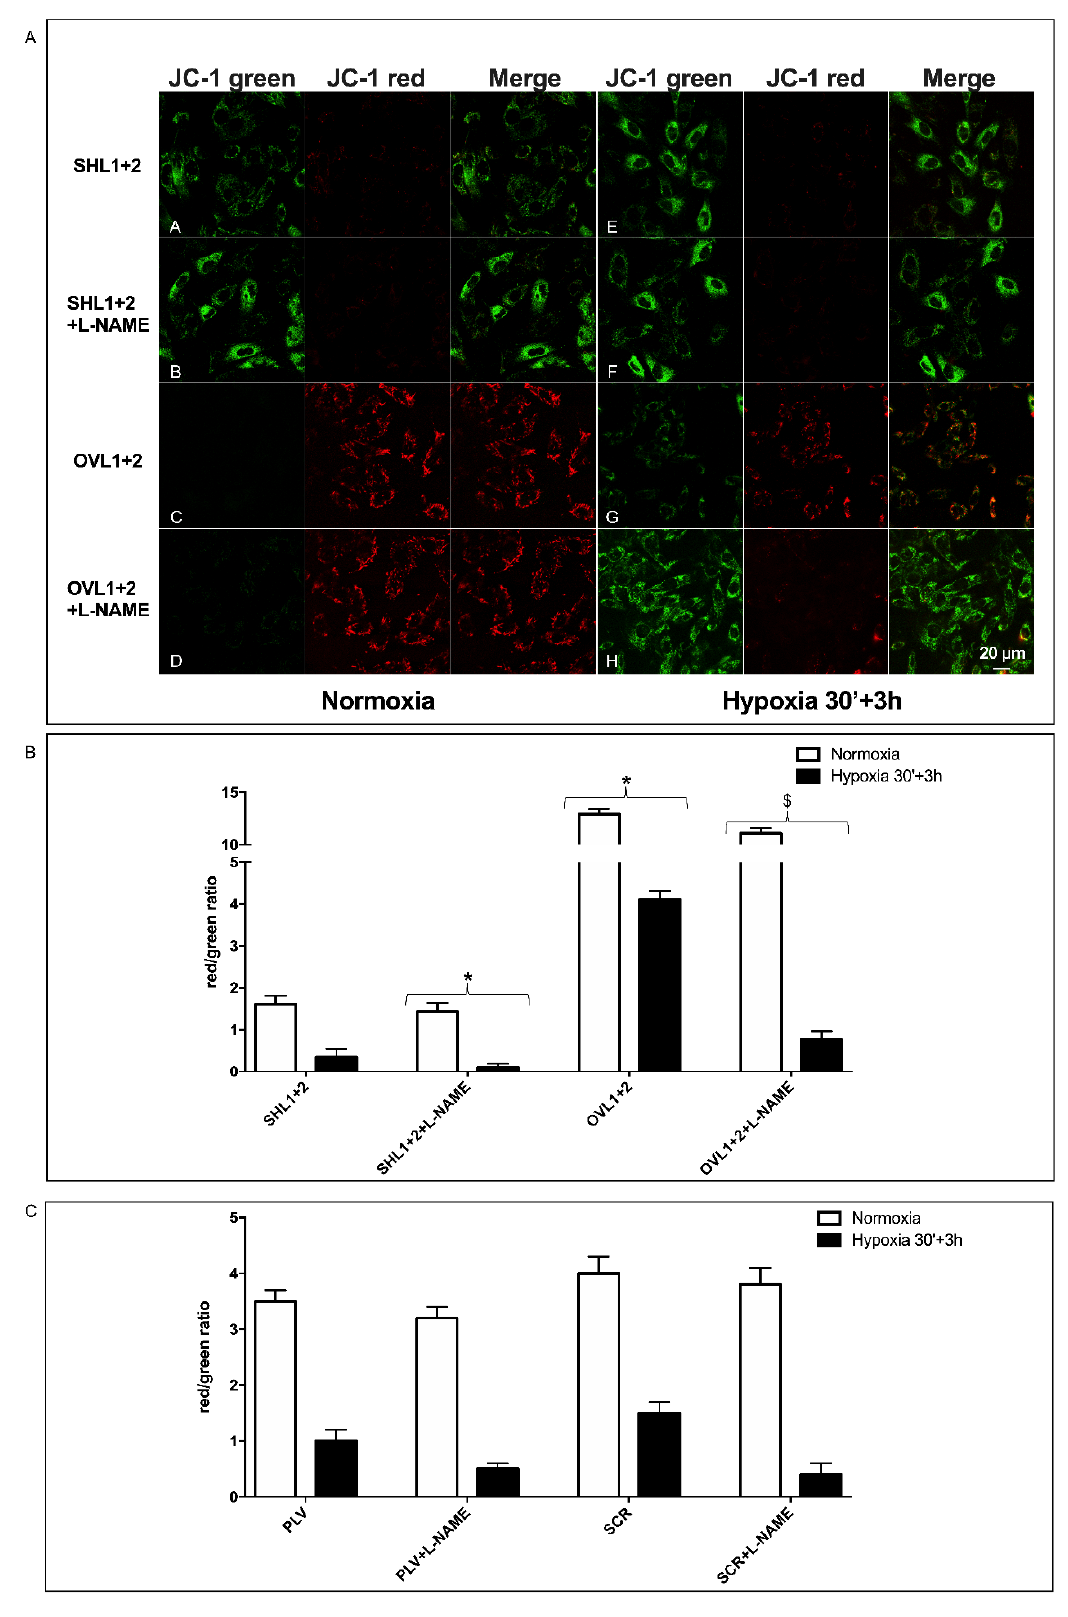
Figure 4. NO-dependent increased mitochondrial proton gradient in LANCL1/2-overexpressing vs. double-silenced H9c2 under normoxia and after hypoxia/reoxygenation. H9c2 cardiomyocytes overexpressing LANCL1 and LANCL2 (OVL1+2), or double-silenced for the expression of both proteins (SHL1+2), were loaded with the mitochondrial proton gradient ( ΔΨ )-sensitive fluorescent